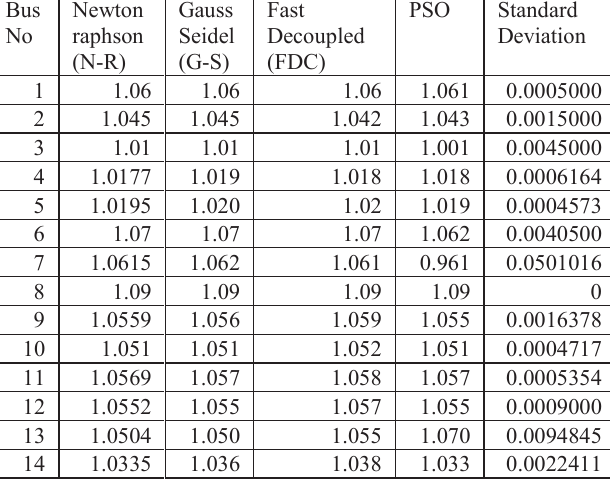
Table 1. Comparison of result